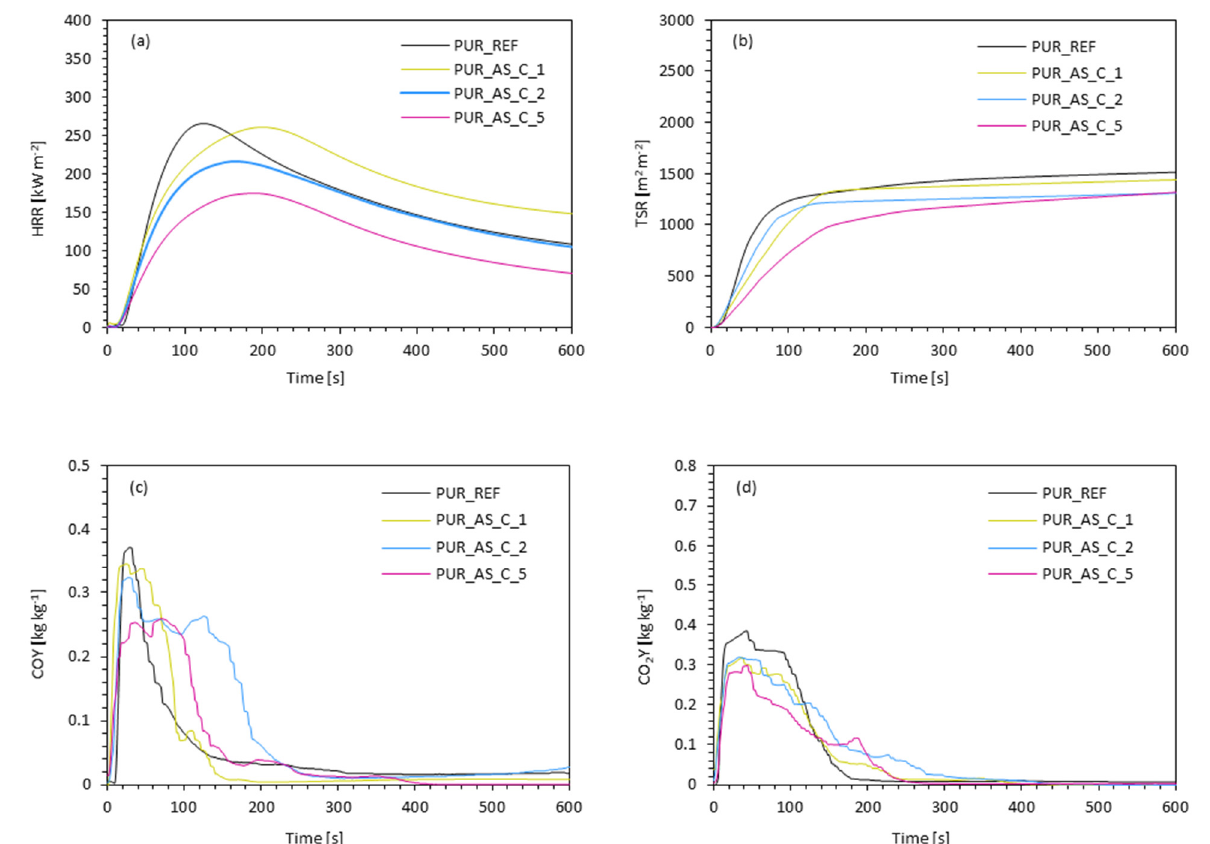
Figure 14. The results of the cone calorimeter test: ( a ) the peak rate of heat release (pHRR), ( b ) the total smoke release (TSR), ( c ) the average yield of CO, and ( d ) the average yield of CO 2 .